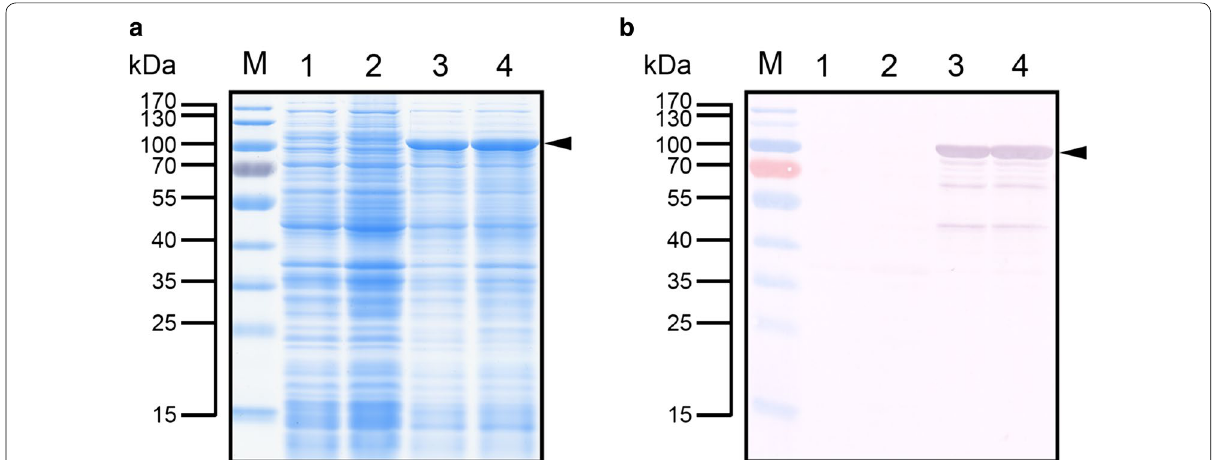
Fig. 1 a SDS‑PAGE and b Western blot analyses of rAgaB‑4 expression in E. coli BL21(DE3). Lane M PageRuler ™ Prestained Protein Ladder; lanes 1 and 2 total cell lysates of E. coli BL21(DE3) containing pET‑29a( ) induced by IPTG at 37 °C for 4 and 24 h, respectively; lanes 3 and 4 total cell lysates + of E. coli BL21(DE3) containing pET‑AGAB‑4 induced by IPTG at 37 °C for 4 and 24 h, respectively. Arrows indicate rAgaB‑4